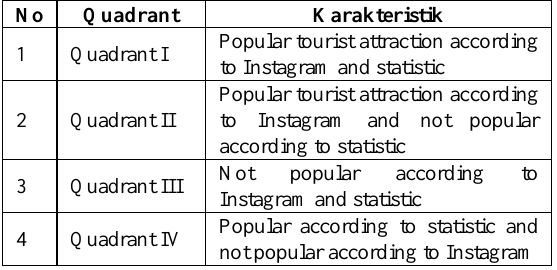
Table 3.1 Visual graphic quadrant